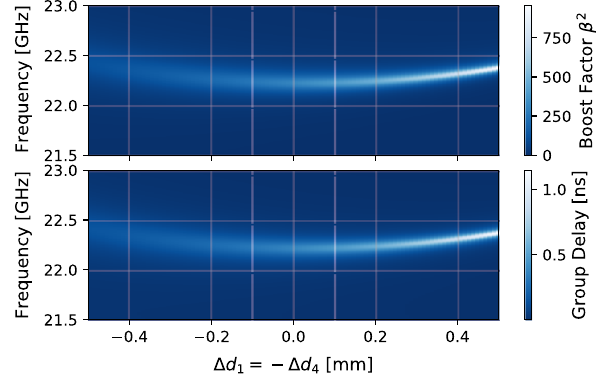
Fig. 10 Simulated boost factor (top) and group delay (bottom) as a function of frequency (vertical axes) and separation between the mirror and first disk (cid:6) d 1 and changing the separation between the third and fourth disk as (cid:6) d 4 = − (cid:6) d 1 , i.e., following the gray line in the leftmost subplot in the bottom row of Fig. 9. The vertical dashed lines indicate the ± 100 µ m range comparable to the range of the correlations in Fig. 9